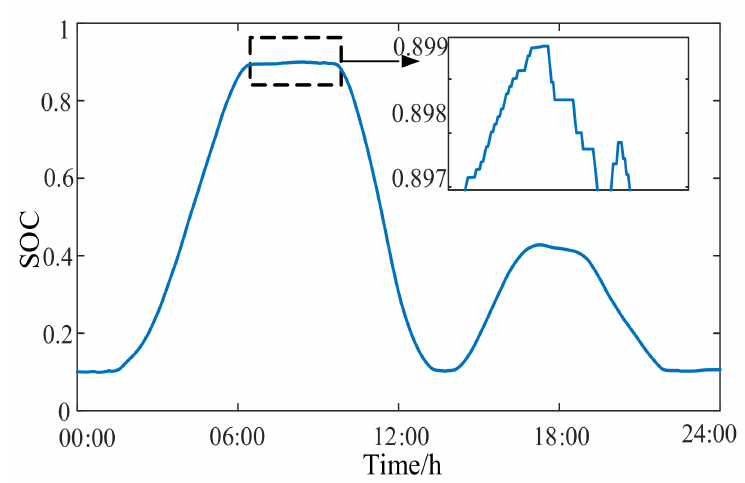
Figure 12. ES SOC in multiple scenarios of peak and